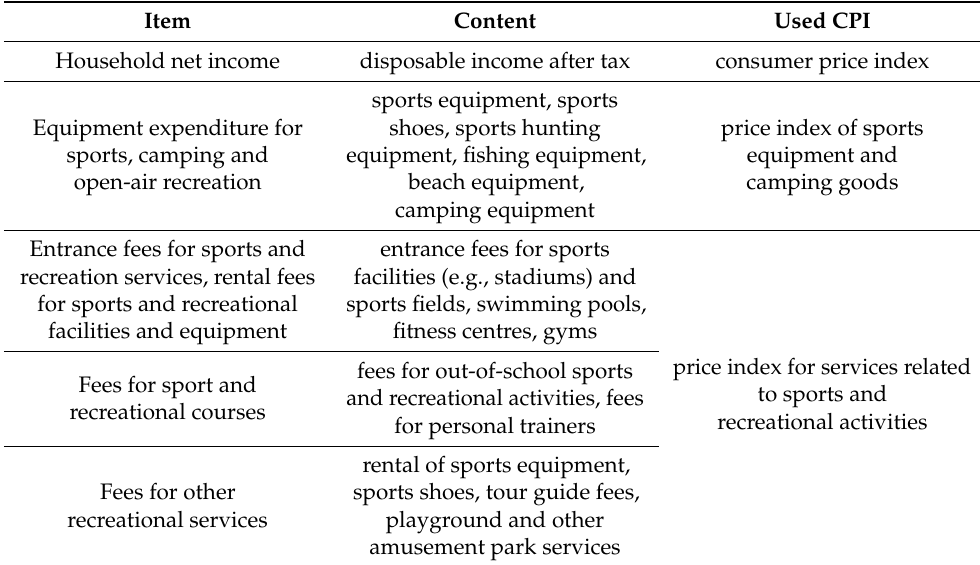
Table 1. Income and sports expenditure items based on COICOP nomenclature and related price